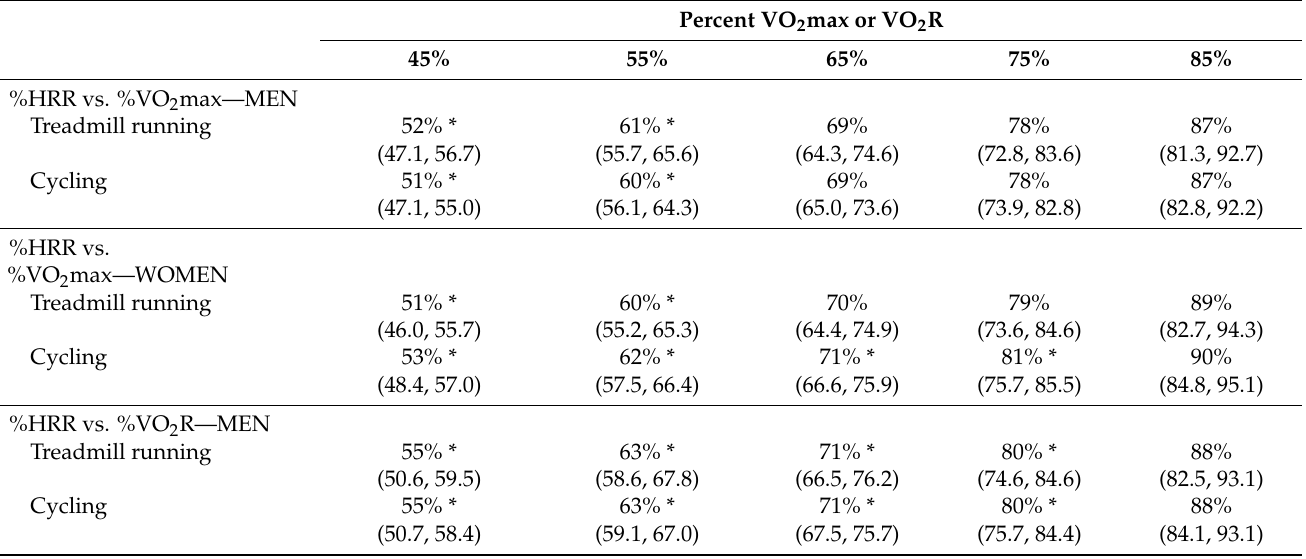
Table 4. %HRR at designated values of %VO 2 max or %VO 2 R